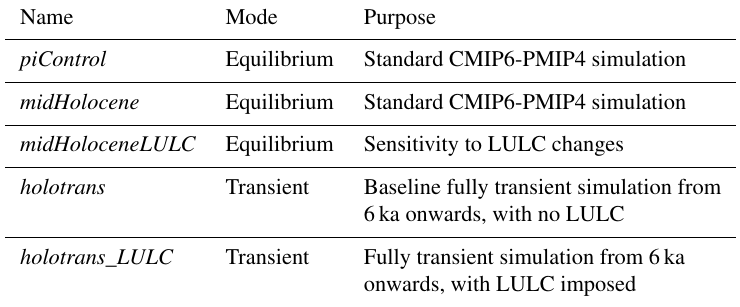
Table 3. Summary of proposed